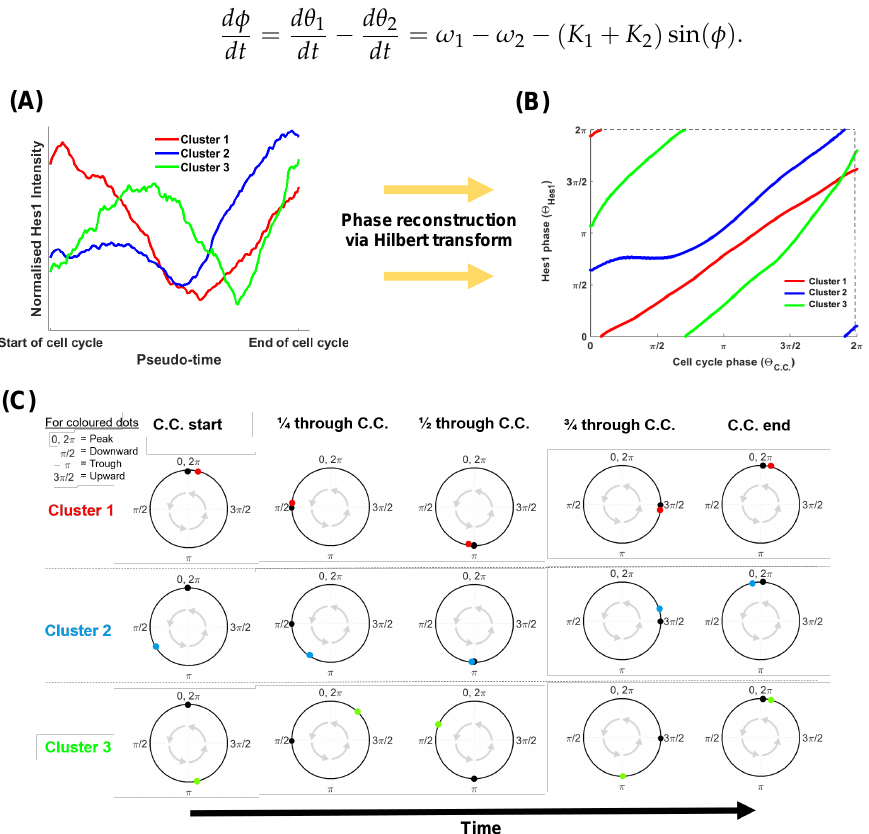
Figure 2. Developing the phase progression data. ( A ) Mean traces of all three clustered, normalised (z- scored) Hes1 traces in pseudo-time. ( B ) A uniformly spaced cell cycle oscillator vector Θ C.C. ∈ [ 0,2 π ) on the x -axis plotted against the Hes1 oscillator phase reconstruction Θ Hes1 of traces from ( A ) found via application of the Hilbert transform forming phase space trajectories on a square torus diagram. ( C ) Alternative view of phase progression between our data vectors Θ Hes1 and Θ C.C. . Both oscillators are represented as points on a circle (coloured dots are the Hes1 and black dots are the cell cycle oscillators), at five snapshotted times within the pseudo-timed cell